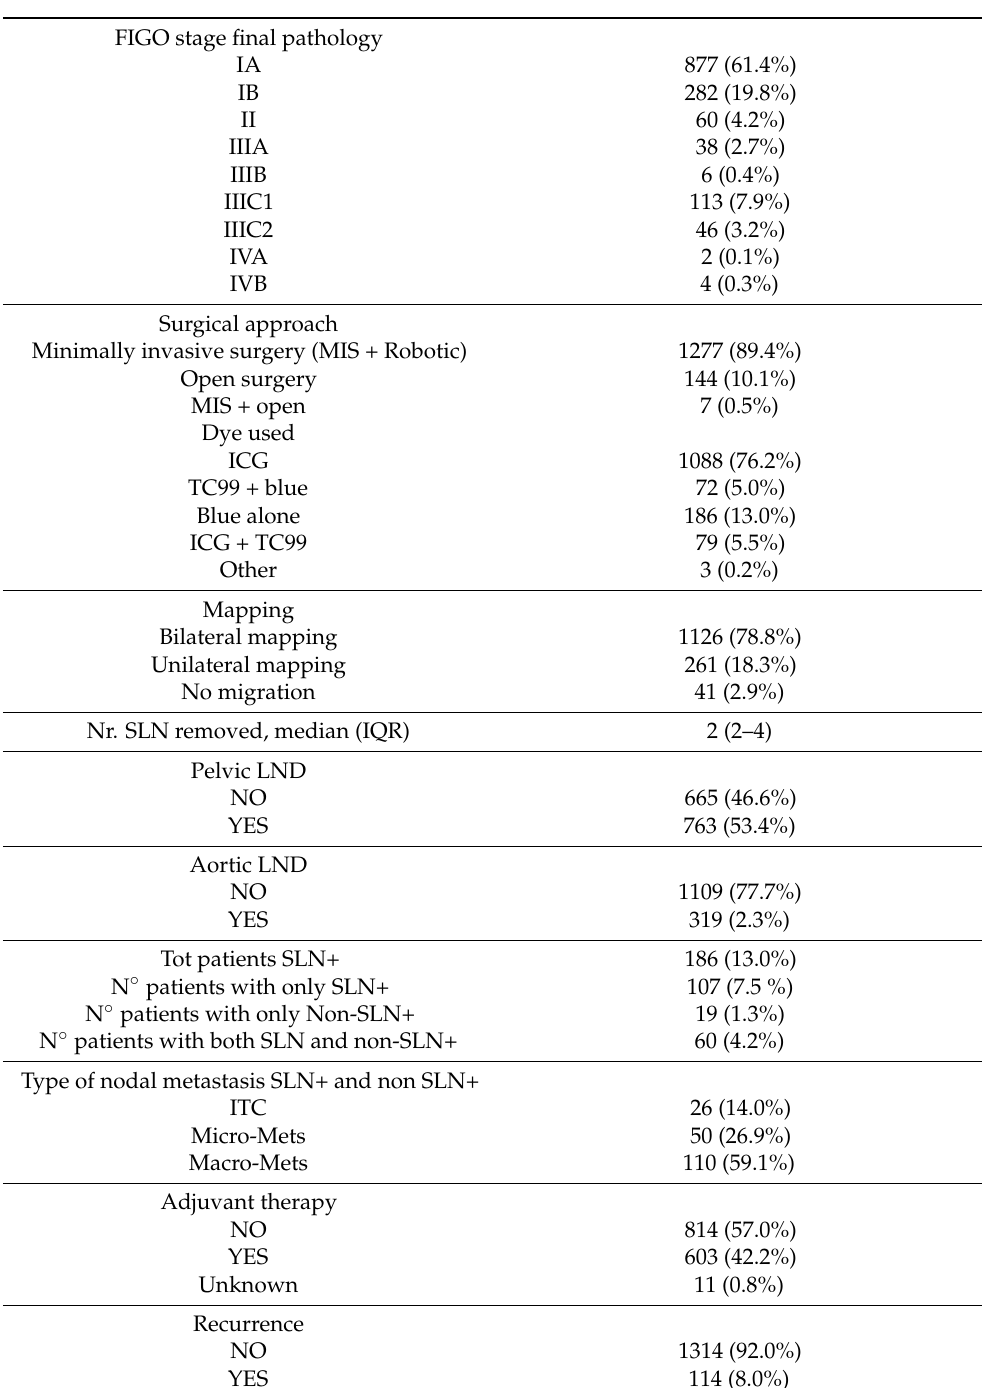
Table 1. Cont . FIGO stage final